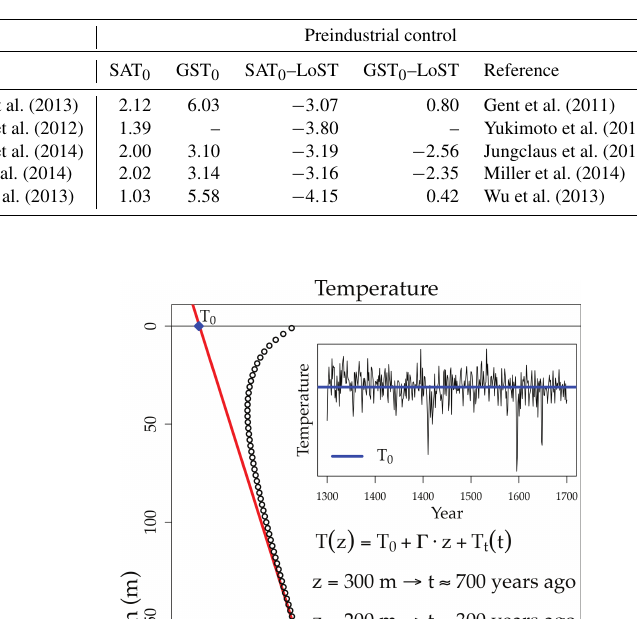
Table 1. Model name, SAT 0 estimates, GST 0 estimates, SAT 0 and GST 0 differences with the mean LoST temperatures and references for each PMIP3/CMIP5 GCM simulation. All results are in degrees Celsius. Ground temperatures for the MRI-CGCM3 piControl simulation could not be retrieved from the PMIP3/CMIP5 data servers. The temperature average of the LoST database is 5.2 ◦ C, with a 95% confidence interval between 5.0 and 5.4 ◦ C.